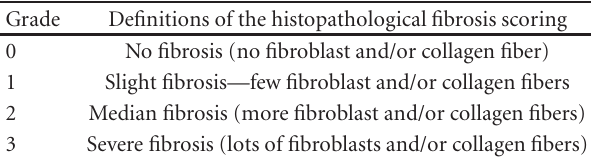
Table 2: Definitions of the histopathological fibrosis